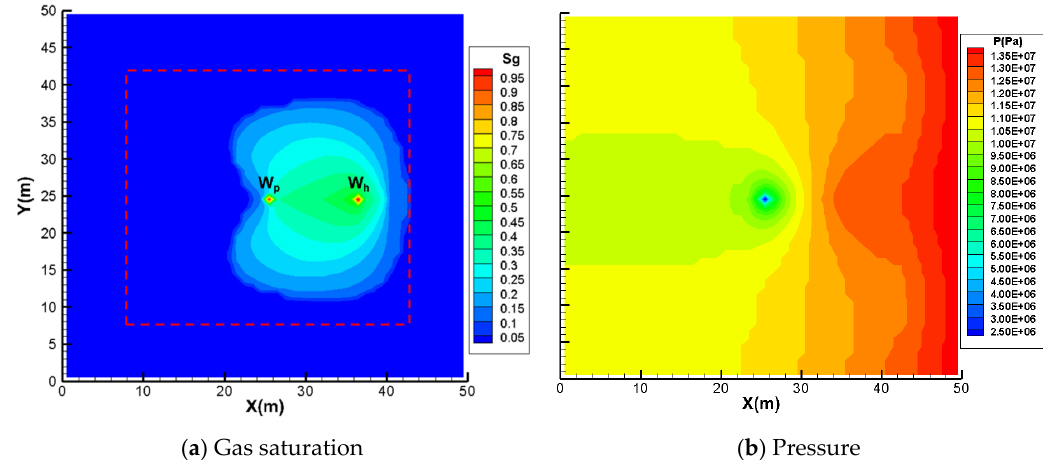
Figure 1. Gas saturation and pressure nephograms after gas injection for 6 months (the red dotted line box represents the hydraulic fracturing area).